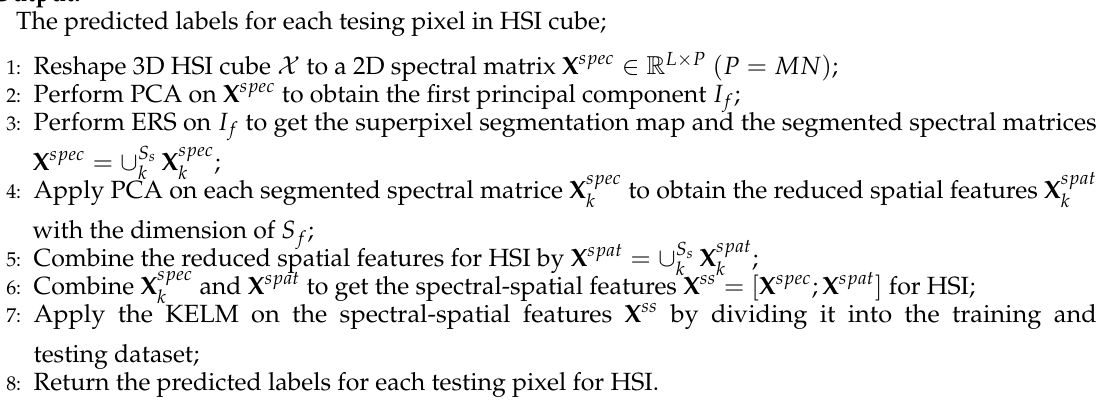
Algorithm 1 Pseudocode. for